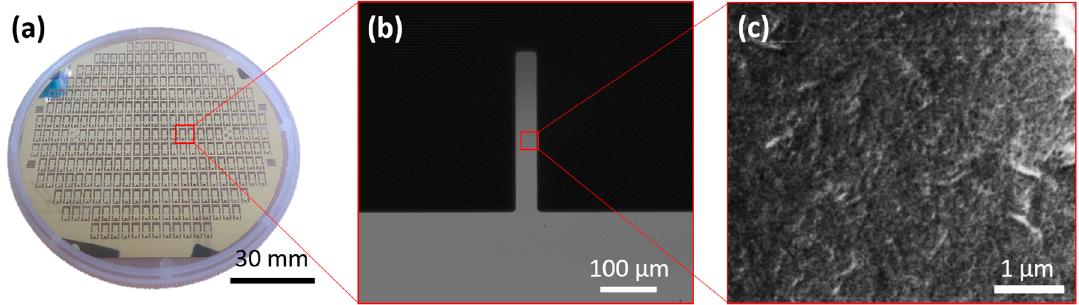
Figure 3. Scalability of the microneedle fabrication. ( a ) Two hundred eighty microneedles in a 100-mm wafer; ( b ) Picture of a microneedle; ( c ) Surface of microneedle uniformly coated with PEI and SWCNTs.